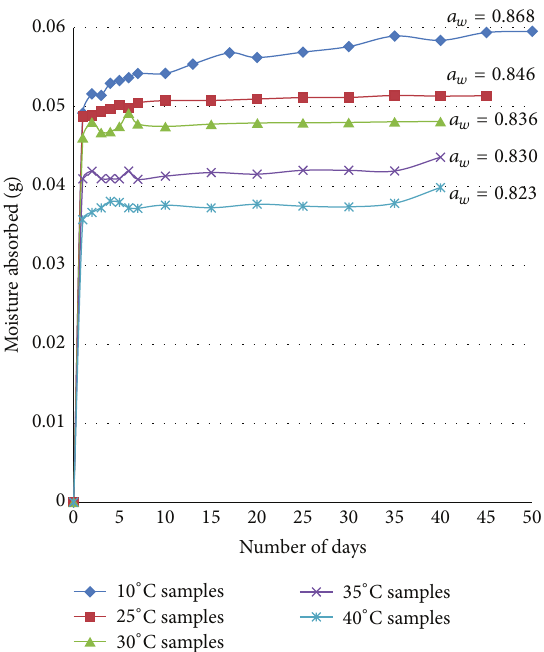
00.010.020.030.040.050.06 Figure 3: Soy/PE fiber samples stored with potassium chloride salt solutions at different temperatures (10 ∘ C, 25 ∘ C, 30 ∘ C, 35 ∘ C, and 40 ∘ C). Ultimate moisture absorbed during storage in different 𝑎 𝑤 (0.868, 0.846, 0.836, 0.830, and 0.823, respectively). Each data point denotes a mean value of 6 samples in 3 replications. Figure 4: Soy/PE fiber samples stored with potassium nitrate salt solutions at different temperatures (10 ∘ C, 25 ∘ C, 30 ∘ C, 35 ∘ C, and 40 ∘ C). Ultimate moisture absorbed during storage in different rel- ative humidities (0.960, 0.936, 0.923, 0.908, and 0.890, respectively). Each data point denotes a mean value of 6 samples in 3